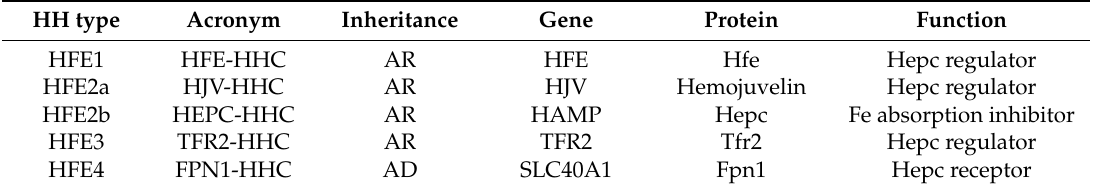
Table 1. Hereditary hemochromatosis (HHC types) and their relationship with